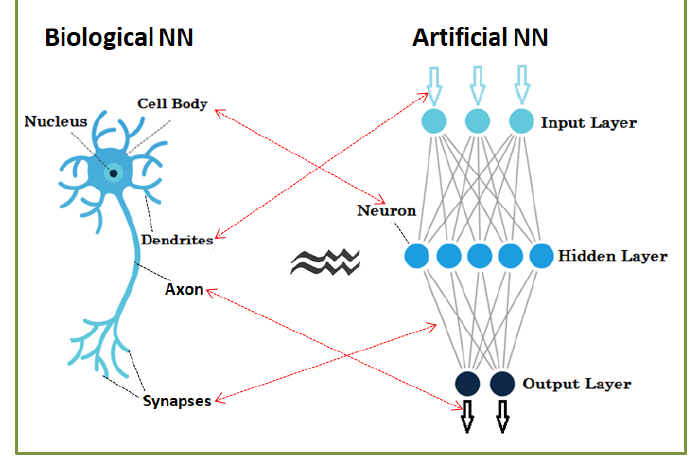
Figure 1. Neural networks—biological and artificial.